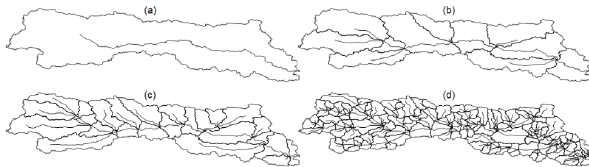
Fig. 3. Configurations of CCW discretization with numbers of sub- basins: (a) N =1, A = 265km 2 , L =38km; (b) N =11, A = 24km 2 , L =64km; (c) N =27, A = 9.8km 2 , L =106km; and (d) N =157, A = 1.7km 2 , L